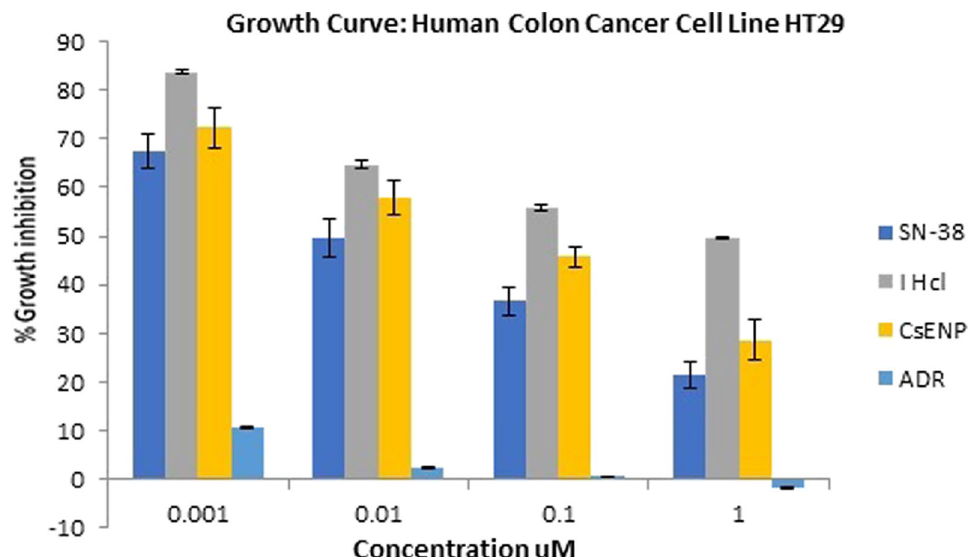
Fig. 3 % Growth inhibition at various concentrations of drugs and formulations for HT-29